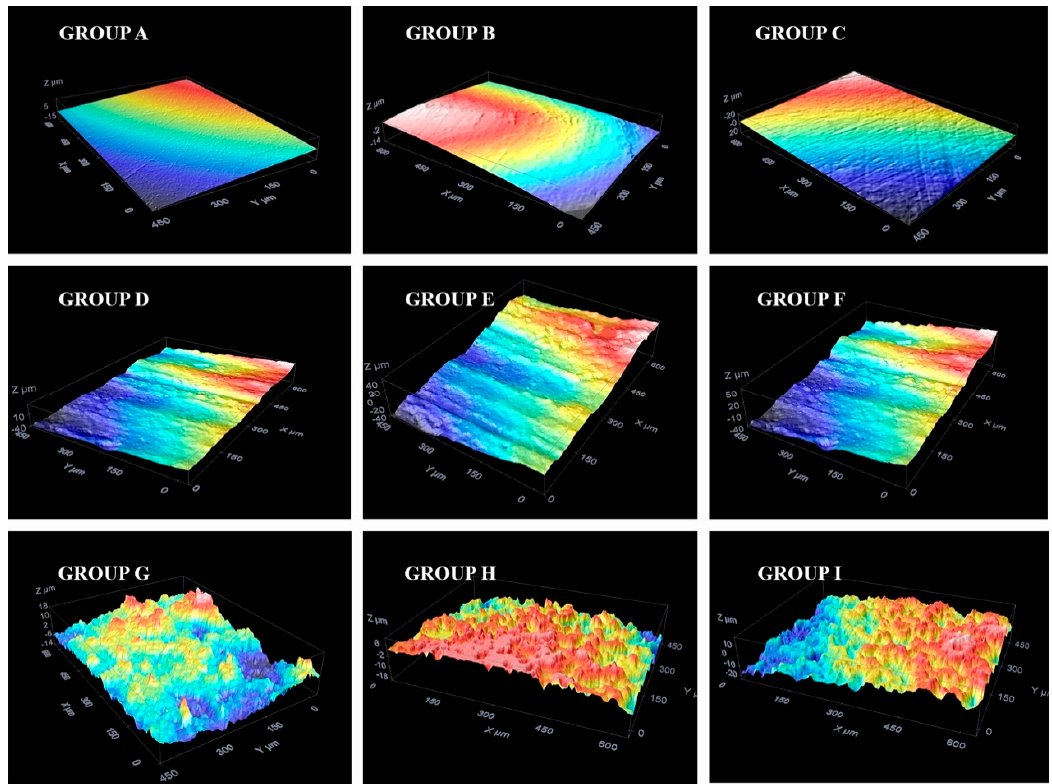
Figure 2. Confocal microscope. Three-dimensional surface topography. Red expresses the peaks; blue shows the depressions. Groups A, B and C show a surface with low irregularities; groups D, E and F show a moderate presence of surface irregularities; groups G, H and I show the highest presence of surface irregularities.